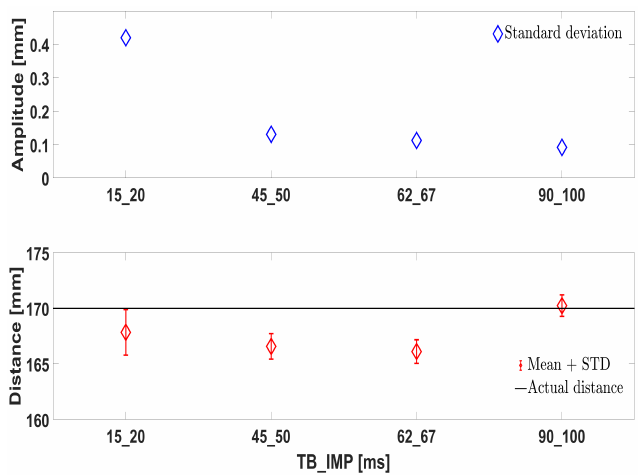
Figure 11. Couples of TB and IMP tested and the consequent PS